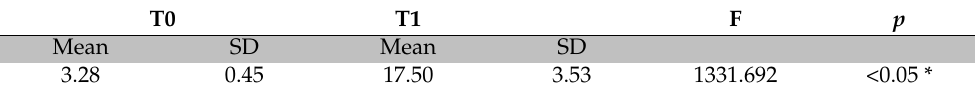
Table 8. Impact of within-factor on task 3 (ESPE). Effect of within factor on task 3 (ESPE).